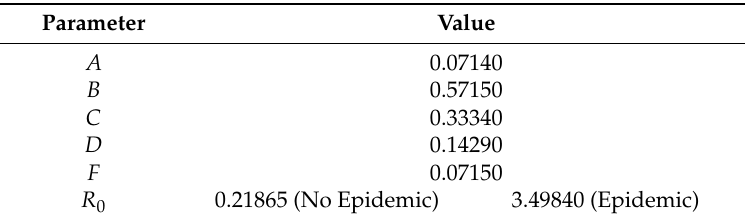
Table 6. Local Stability ( β = 1